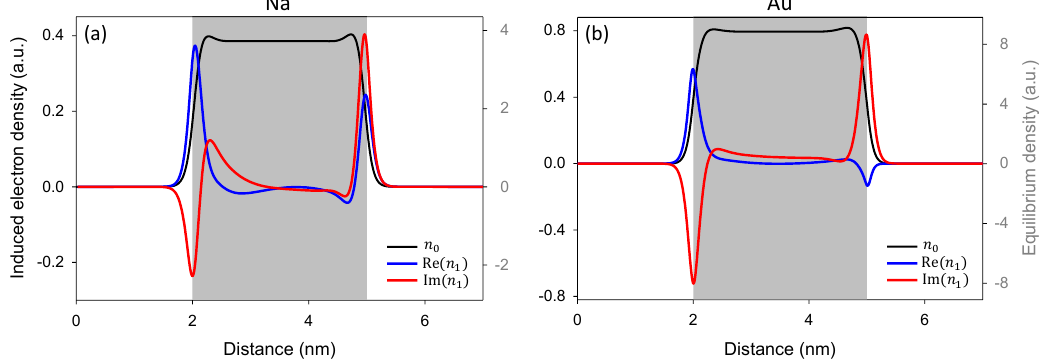
Figure 4. Equilibrium density n 0 and real and imaginary parts of the induced charge density n 1 for ( a ) Na and ( b ) Au nanoshell with shell thickness t s = 3 nm ( R 1 = 2 nm and R 2 = 5